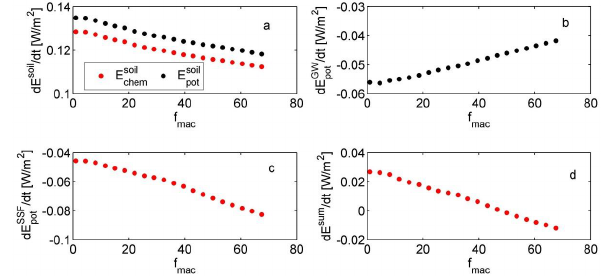
Figure 12: Temporal averaged change rates of free energy during rainfall driven conditions Fig. 12. Temporally averaged change rates of free energy during for numerical experiment 3 in Malalcahuello plotted against the macroporosity factor: Change rainfall-driven conditions for numerical experiment 3 in Malalc- rates of total free energy in soil water and potential energy of soil water (panel a), potential ahuello plotted against the macroporosity factor: change rates of total free energy in soil water and potential energy of soil water (a) , energy export by ground water recharge (panel b) and subsurface storm flow (panel c) as well potential energy export by groundwater recharge (b) and subsurface as the sum of the changes rates in free energy storage ins soil and free energy export by runoff storm flow (c) as well as the sum of the changes rates in free energy (panel c) defined after Eq. 9. storage in soil and free energy export by runoff (c) defined after Eq. (9).